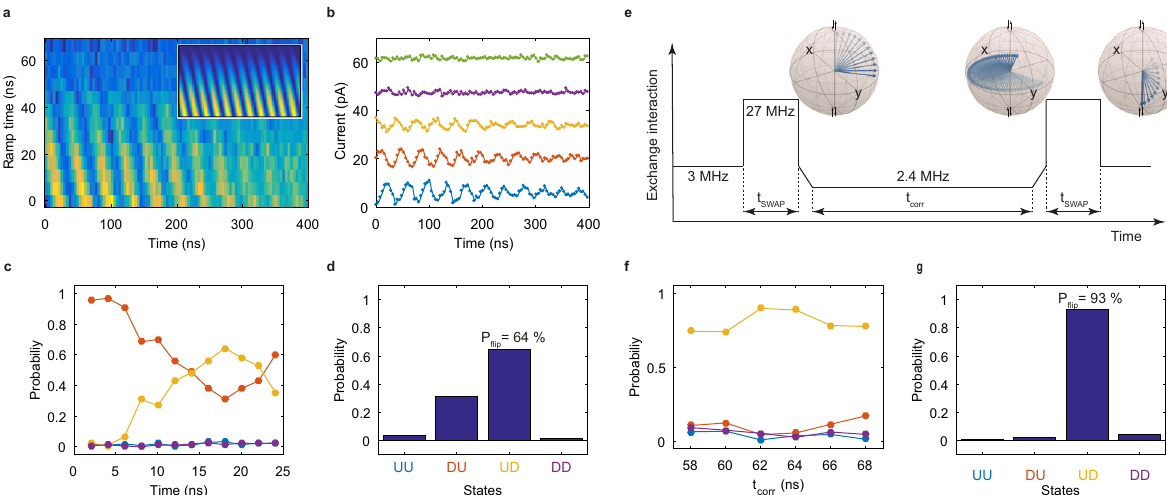
Fig. 3 Pulsed SWAP and composite exchange pulse for high- fi delity SWAP at T = 1.05 K. a , b SWAP oscillations as a function of the ramp time for a detuning pulse such that J = 23 MHz. When the pulsing becomes adiabatic with respect to variations in J , the exchange oscillations are suppressed. In order to maximize the readout signal we project the "#